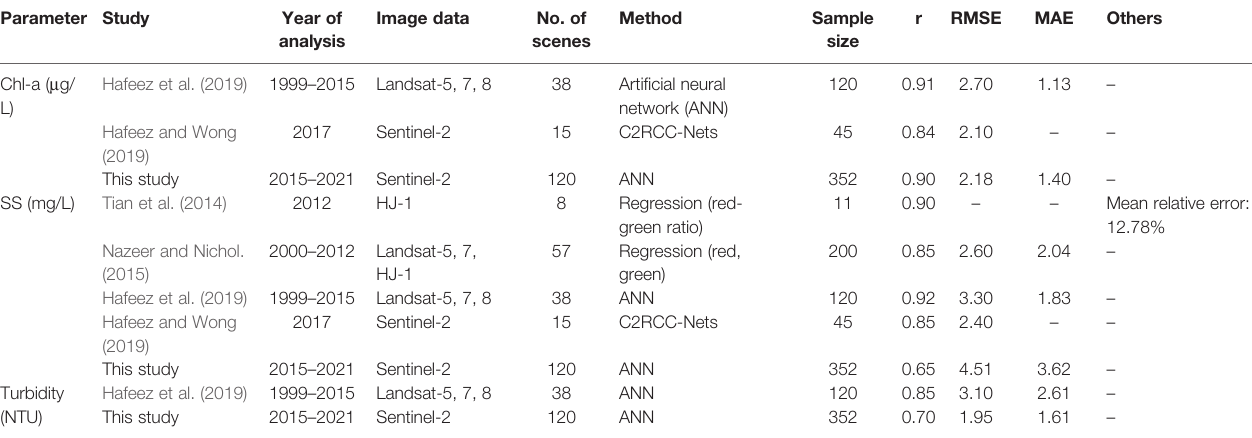
TABLE 6 | Comparison of modeling results with other studies focusing on Hong Kong waters. Parameter